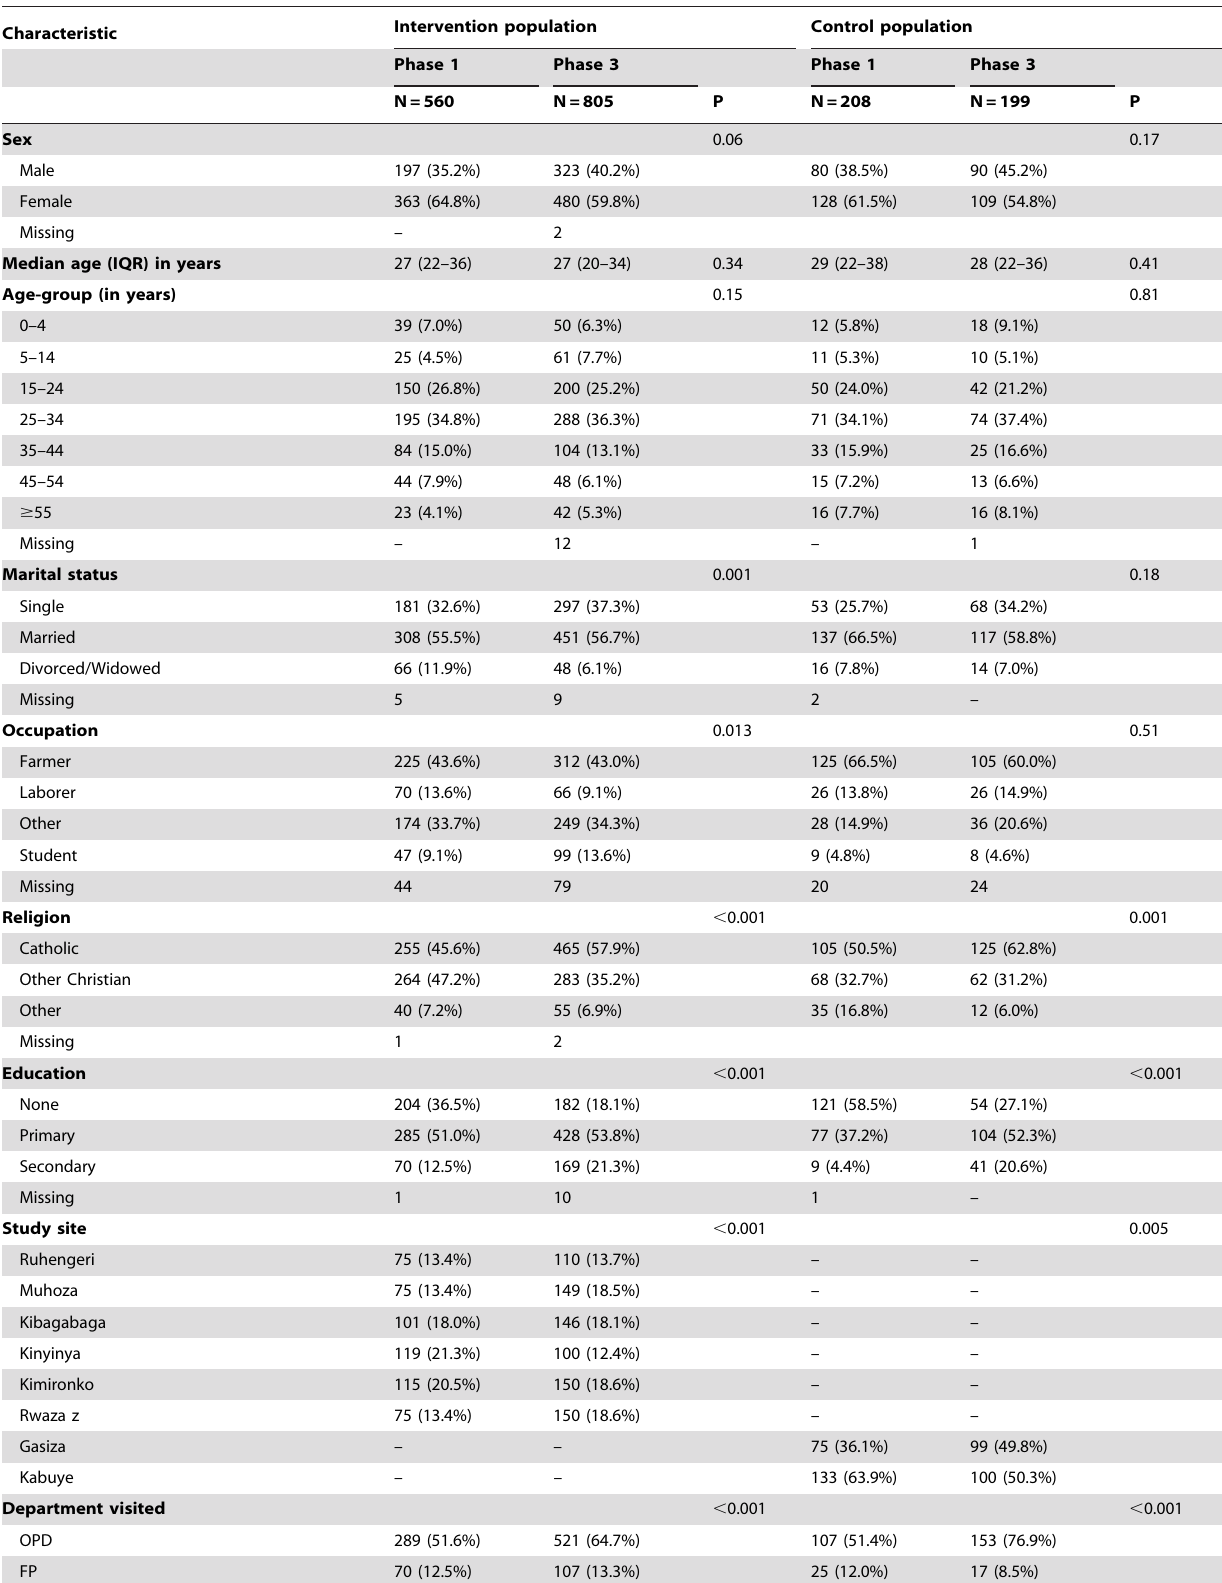
Table 2. Characteristics of clinic attendees interviewed at intervention and control sites, PITC study, Rwanda,